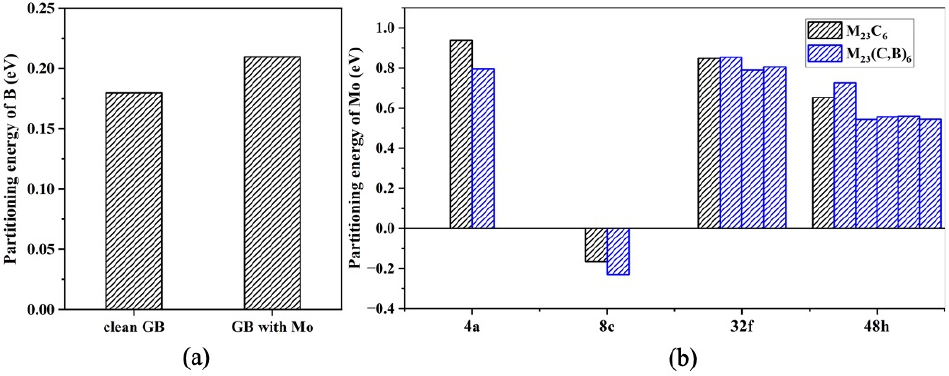
Figure 4. Energy required for B ( a ) and Mo ( b ) to partition from GB into M 23 C 6 and M 23 (C,B) 6 .